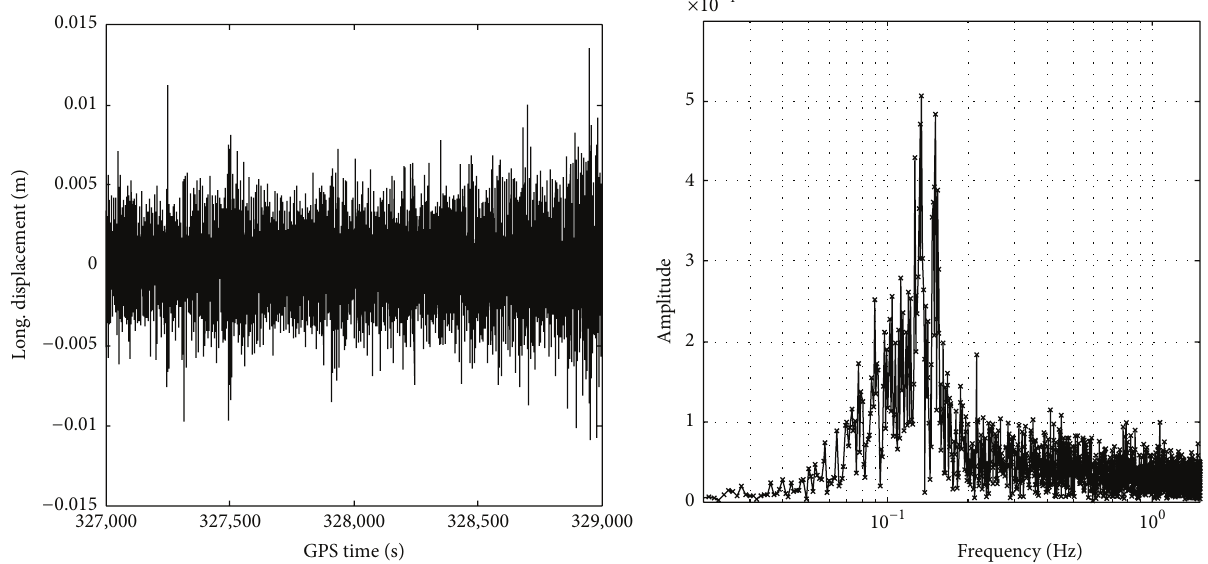
Figure 19: The filtered longitudinal displacements and corresponding frequencies during the wind speed increasing period.